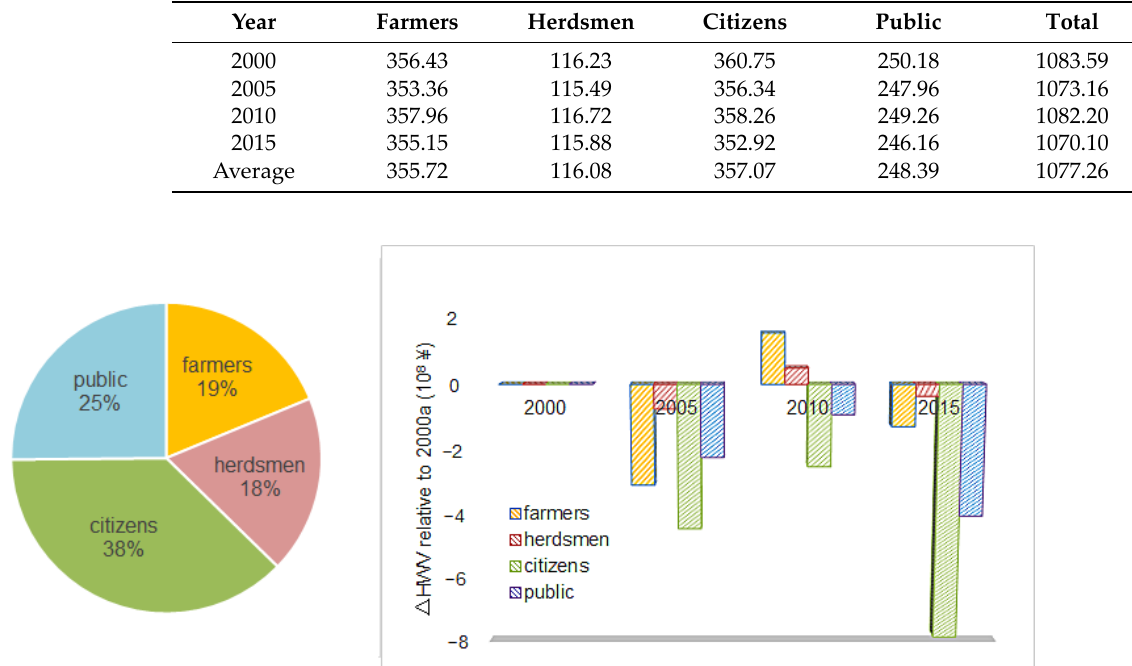
Figure 8. Proportions ( left ) and relative annual dynamics ( right ) of